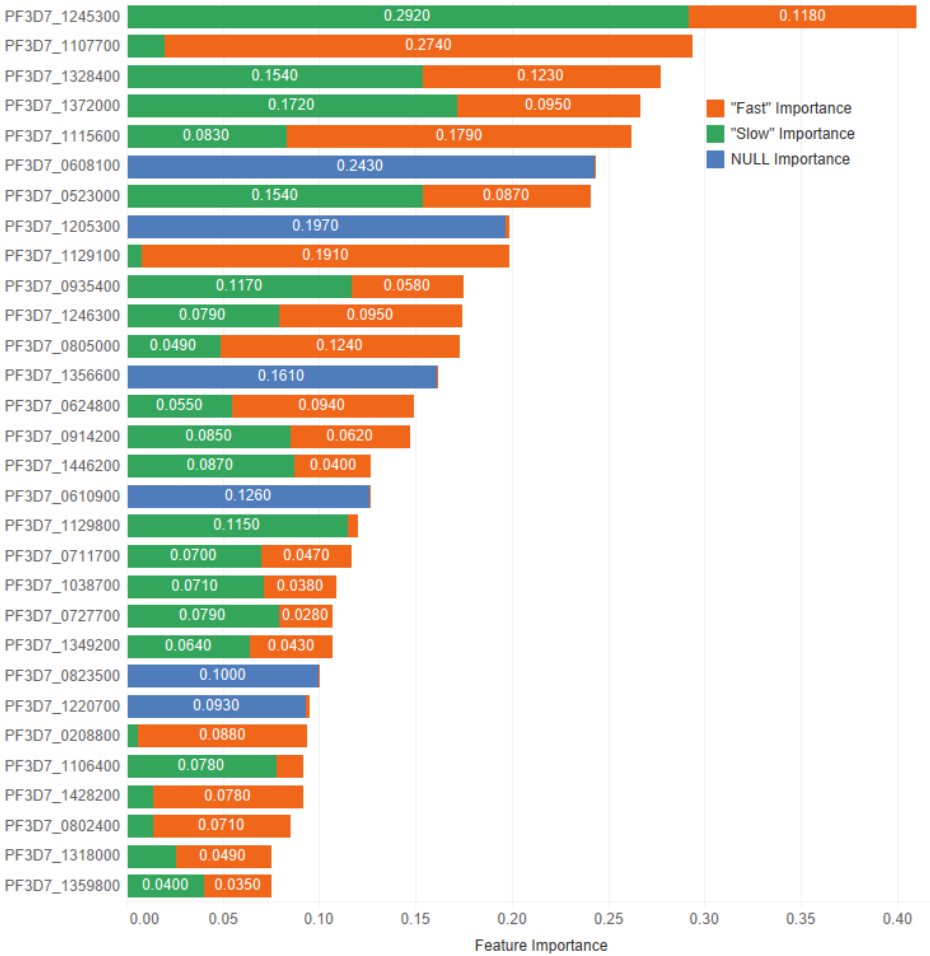
Figure 6. Derived feature importances using the black box mimic model explanation of the clearance rate model. (Shown: Top 30